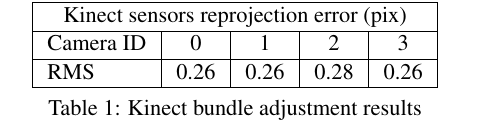
Table 1: Kinect bundle adjustment results